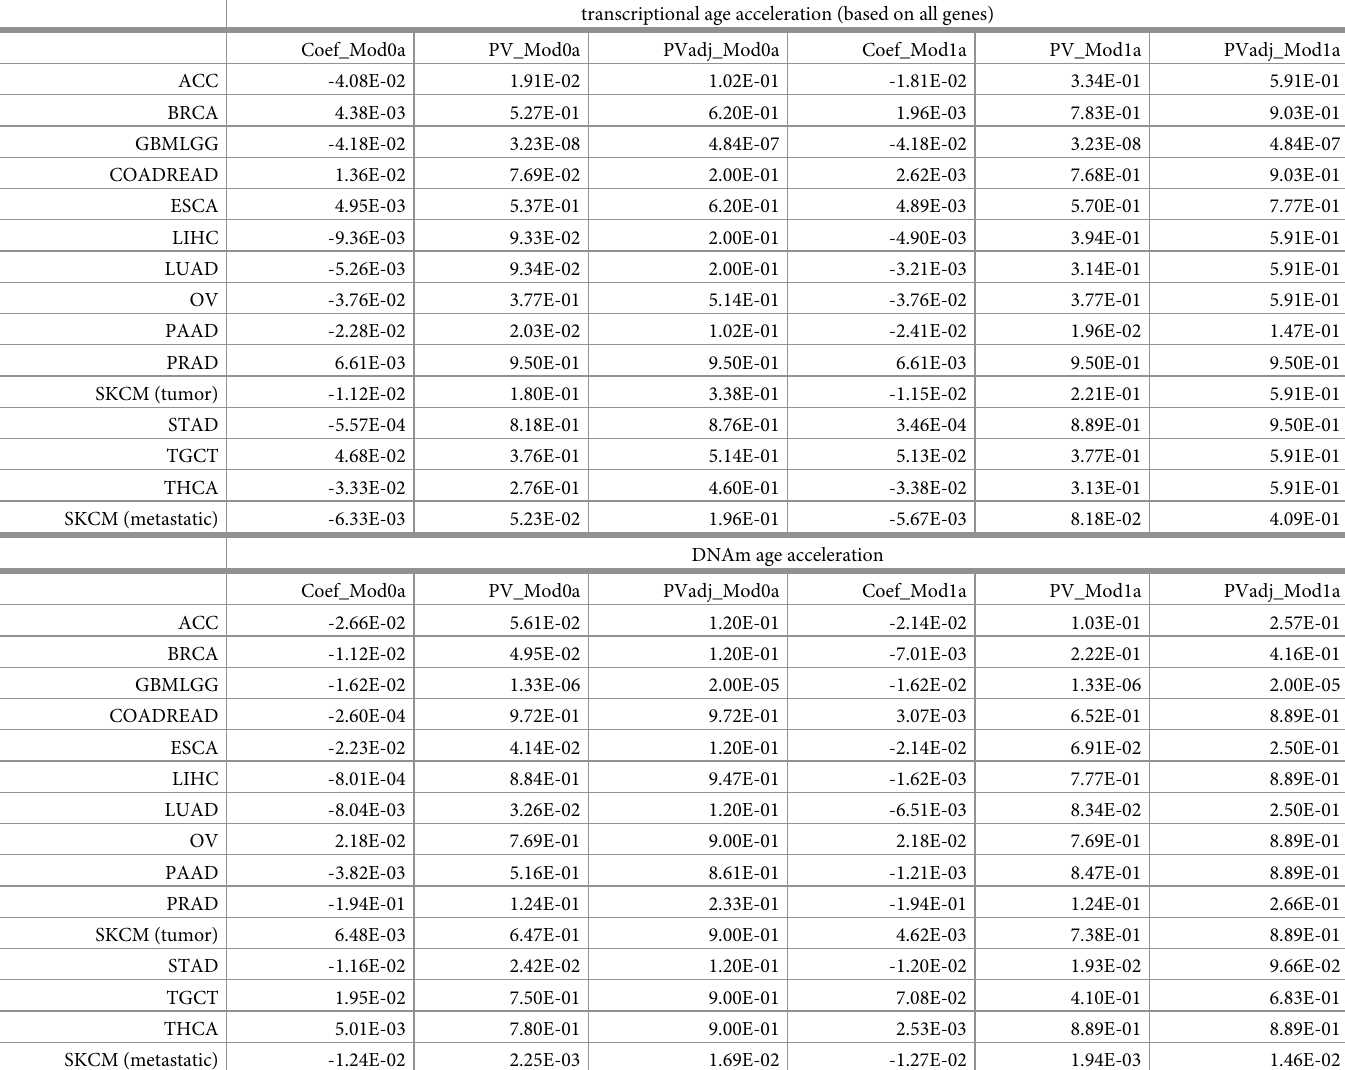
Table 3. Coefficient and p-value of age acceleration residual from Cox